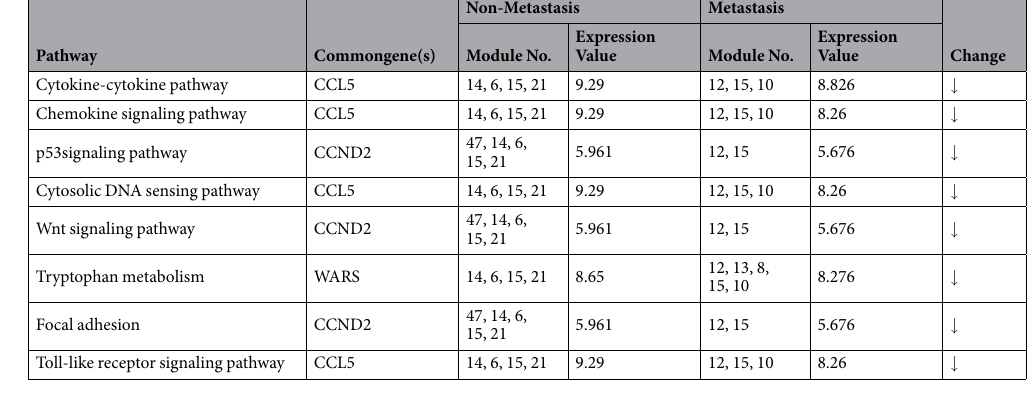
Table 3. Expression value of genes involved in common pathways in both the